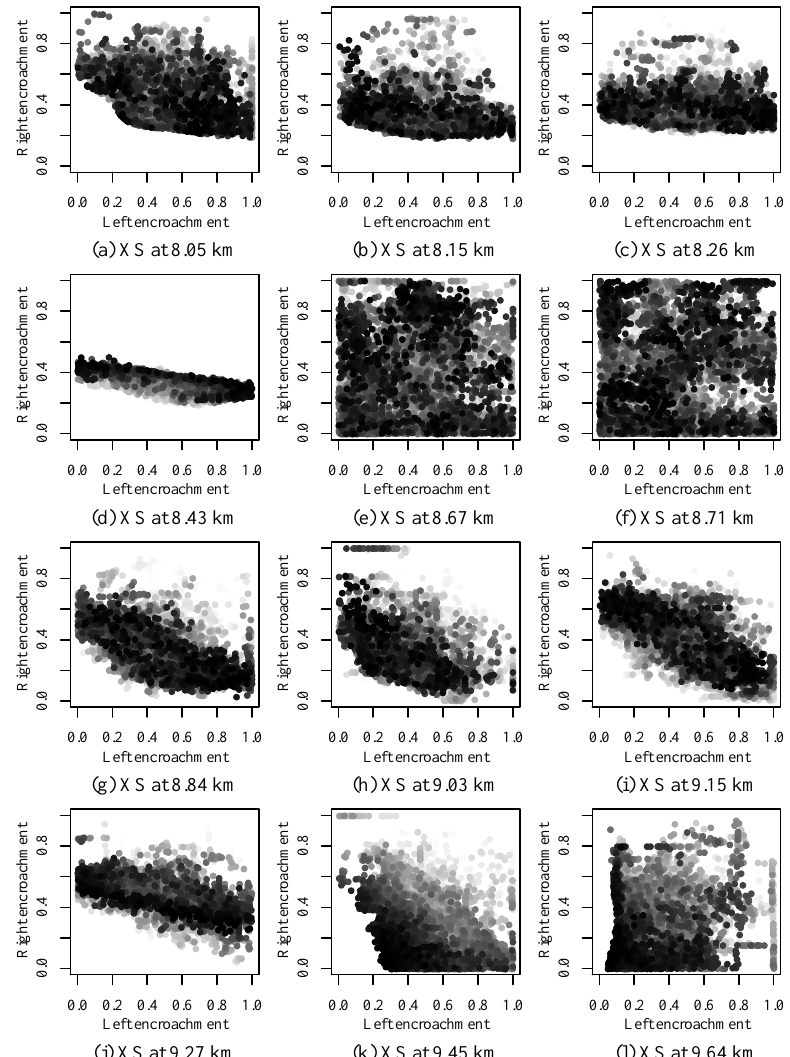
[ 0,1 ] D for 1 i S satisfying ∈ ≤ ≤